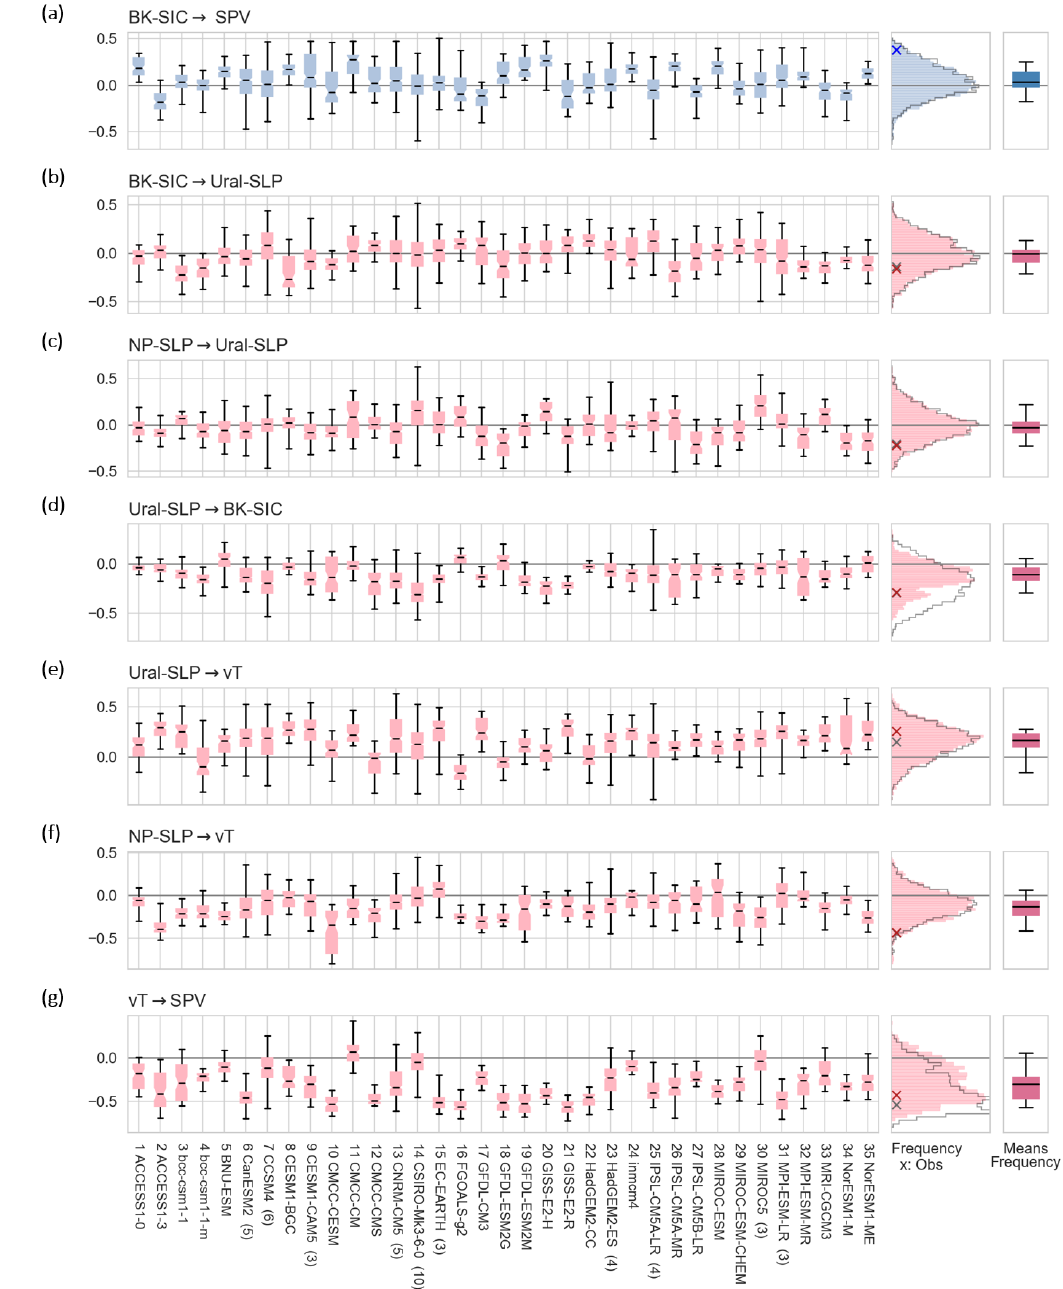
Figure 4. Individual links of Arctic–stratosphere pathway. Links from (a) seasonal-mean BK-SIC (in OND) to SPV (in JFM) and from (b) monthly BK-SIC (in N) to Ural-SLP (in J), (c) NP-SLP (in D) to Ural-SLP (in J), (d) Ural-SLP (in N) to BK-SIC (in D), (e) Ural-SLP (in D) to vT (in J), (f) NP-SLP (in D) to vT (in J), and (g) vT (in J) to SPV (in F). What is shown is the spread in link strength for each model (left panels) and the distribution of all link strengths (middle panels) and of the models’ means (right panels). The link strengths are quantified by regressing each variable on their parents (see Fig. 3) for each model over 39-year moving windows from 1900 to 2005 (in total 67 windows) in the historical simulations. Grey contours in the middle panel show the histogram obtained using (unadjusted) regression. The crosses in the middle panel denote the link strength obtained using observations (grey for unadjusted regression and coloured crosses for regressions including all parents). Numbers in brackets after model names on the x axis indicate the number of ensemble members used, with no number meaning that just one member was used. The box and whisker plots thus include different amounts of data (number of ensemble members times the 67 moving windows). The boxes indicate the inter-quartile range, the whiskers represent the upper and lower quartile ranges, and horizontal lines show the